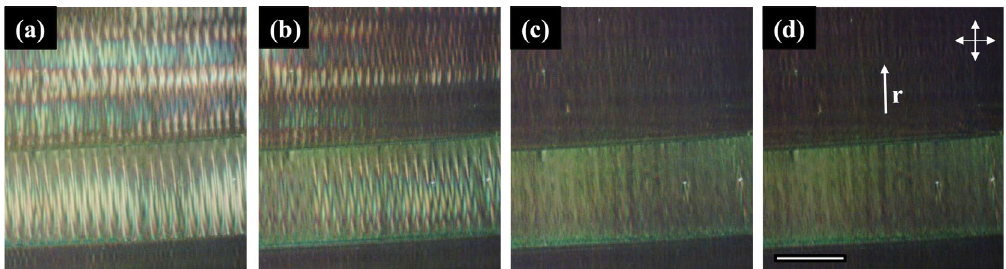
FIG. 20. Stripe instabilities in the monochiral N domains of BP12 (a) and their annealing after thermal cycling and repeated TB application of a weak electric field ( T ¼ 108 . 0 °C, d ¼ 9 . 8 μ m). After annealing (b) – (d), the domains are again uniform and their optic axis N is parallel to the rubbing direction r . The weak residual heterogeneities after annealing (d) are due to the surface memory of the alignment layers. (Scale bar 100 μ m.)